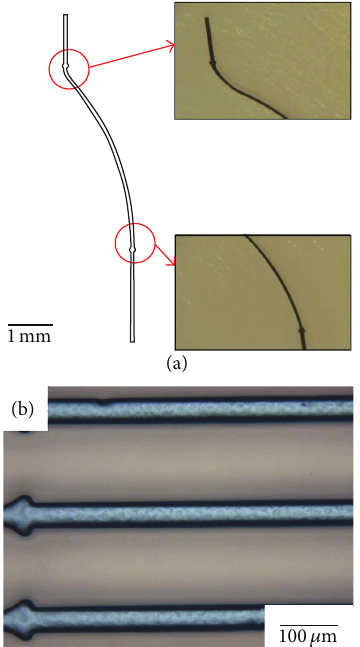
Figure 6: The fabricated probe structure of Ni-Mn alloy: (a) dimen- sions of the probe, (b) the enlarged view of the electrodeposited probe before being released from the pattern.